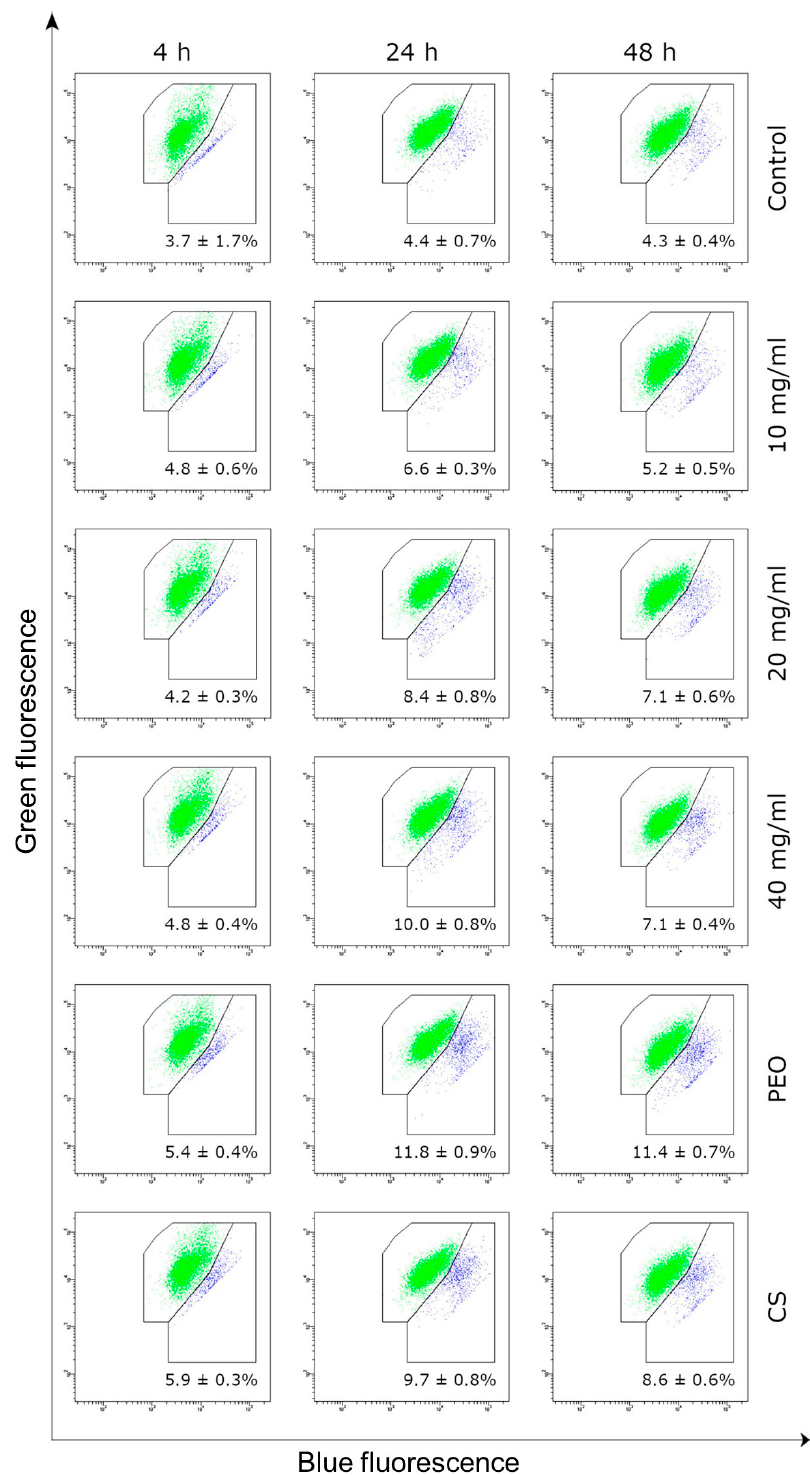
Figure 8. Representative dot-plots displaying the mitochondrial membrane potential of HDFa fibrob- last cells incubated for 4, 24 or 48 h with CS/PEO 10% extract in concentration range 10–40 mg/mL measured by JC-1 fluorescence (green-cells with normal MMP, blue-with decreased MMP); data em- bedded in each dot-plot (as mean for three independent measurements) represents the percent of cells with decreased MMP; untreated cells (K0), cells treated with pure CS and pure PEO at concentrations corresponding to those in sample CS/PEO 10% at 40 mg/mL were used as